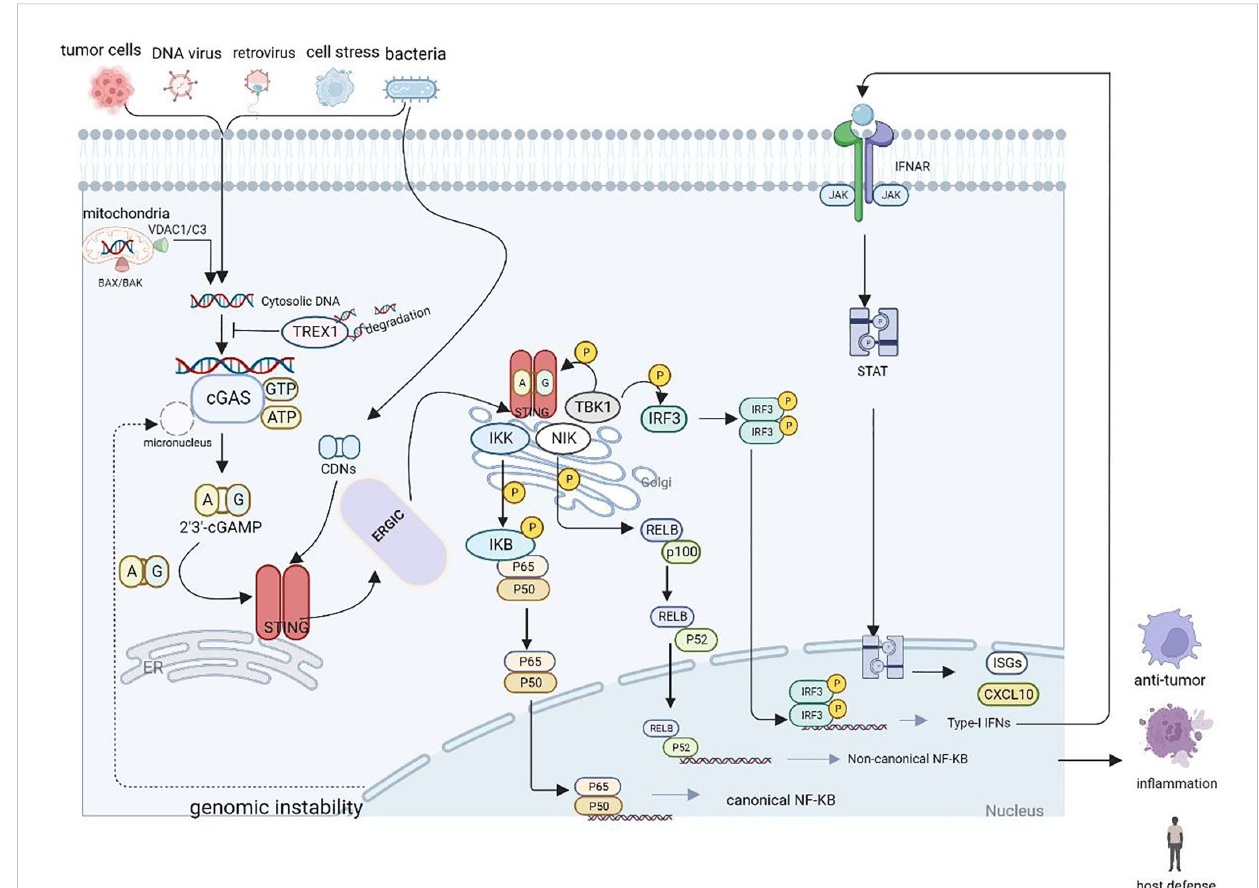
FIGURE 1 Schematic representation of the cGAS-STING cascade. DNA derived from various sources including viruses, dying tumor cells or nuclei and mitochondria binds to and activates the cytosolic DNA sensor cGAS. cGAS catalyzes the synthesis of 2 ′ 3 ′ -cGAMP in the presence of ATP and GTP, and then 2 ′ 3 ′ -cGAMP binds to the ER adaptor STING, which also can be activated by CDNs derived from bacteria. Upon activation, STING translocate from the ER to the Golgi compartments, where it activates TBK1 and IKK, which phosphorylate IRF3 and I k B a